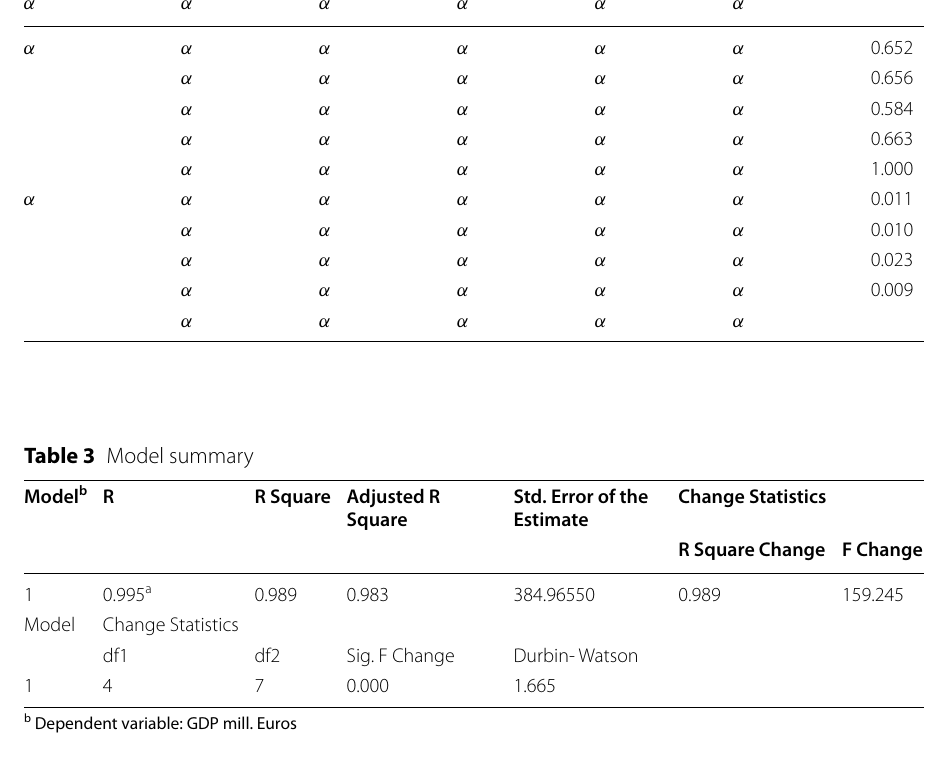
b Dependent variable: GDP mill.